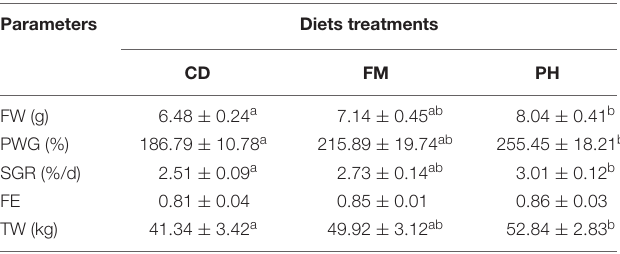
TABLE 6 | Growth performance of shrimps fed with different experimental diets for 6 weeks.